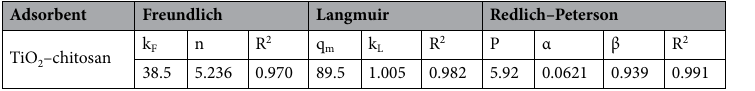
Table 5. Isotherm parameters for COD removal applying the TiO 2 –chitosan composite.